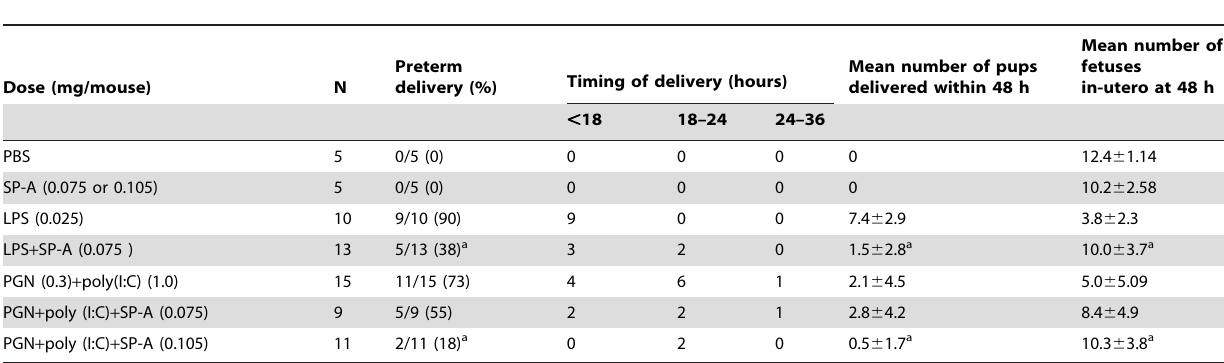
Table 1. Intrauterine SP-A suppresses TLR ligand-induced preterm delivery and leads to higher rates of retention of fetuses in utero